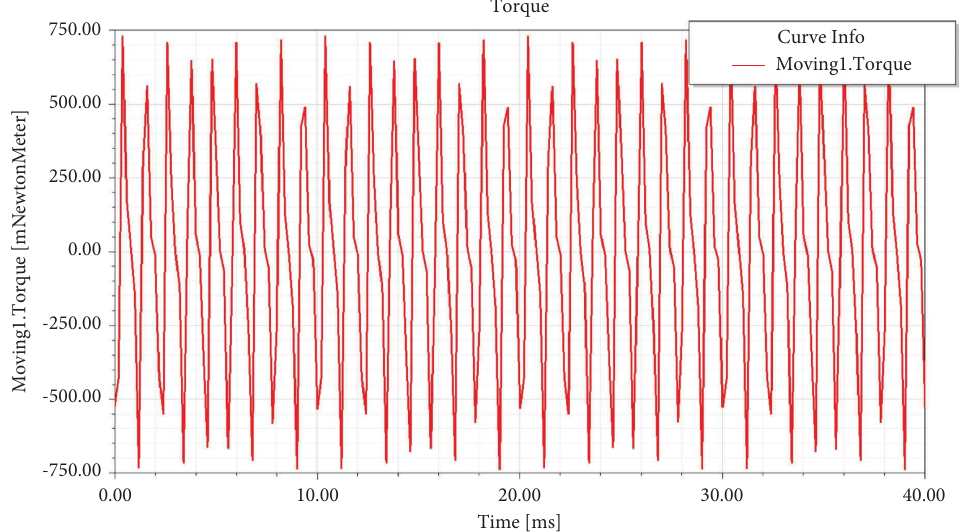
Figure 10: Reluctance torque curve of 4-pole 18-slot motor.